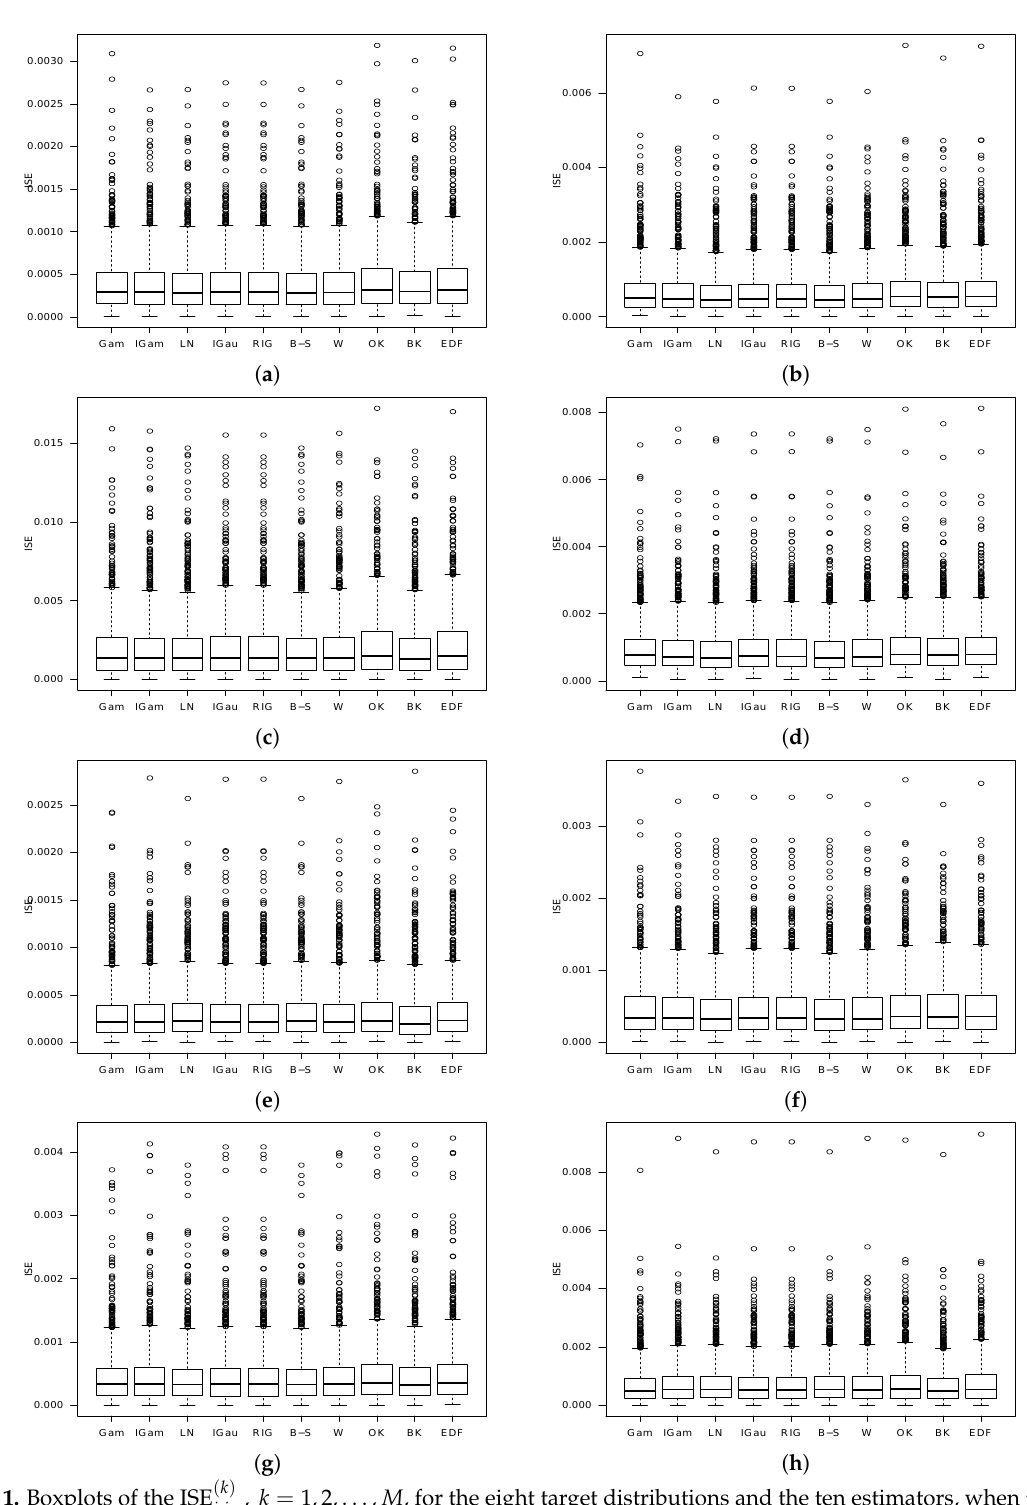
( k ) Figure 1. Boxplots of the ISE , k = 1,2, . . . , M , for the eight target distributions and the ten estimators, when the sample i , j , n size is n = 1000. ( a ) Burr ( 1,3,1 ) . ( b ) Gamma ( 0.6,2 ) . ( c ) Gamma ( 4,2 ) . ( d ) GeneralizedPareto ( 0.4,1,0 ) . ( e ) HalfNormal ( 1 ) . ( f ) LogNormal ( 0,0.75 ) . ( g ) Weibull ( 1.5,1.5 ) . ( h ) Weibull ( 3,2 )